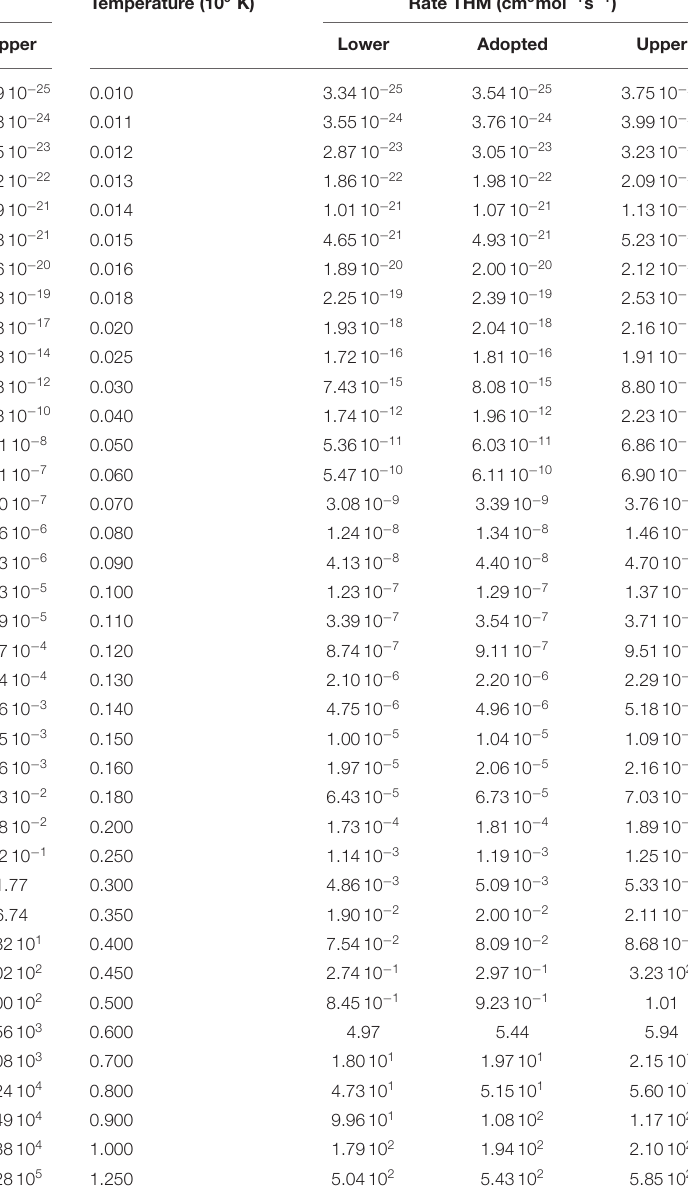
TABLE 3 | Rate of the 17 O( p , γ ) 18 F